Question: Write a single sentence explaining what this figure depicts.
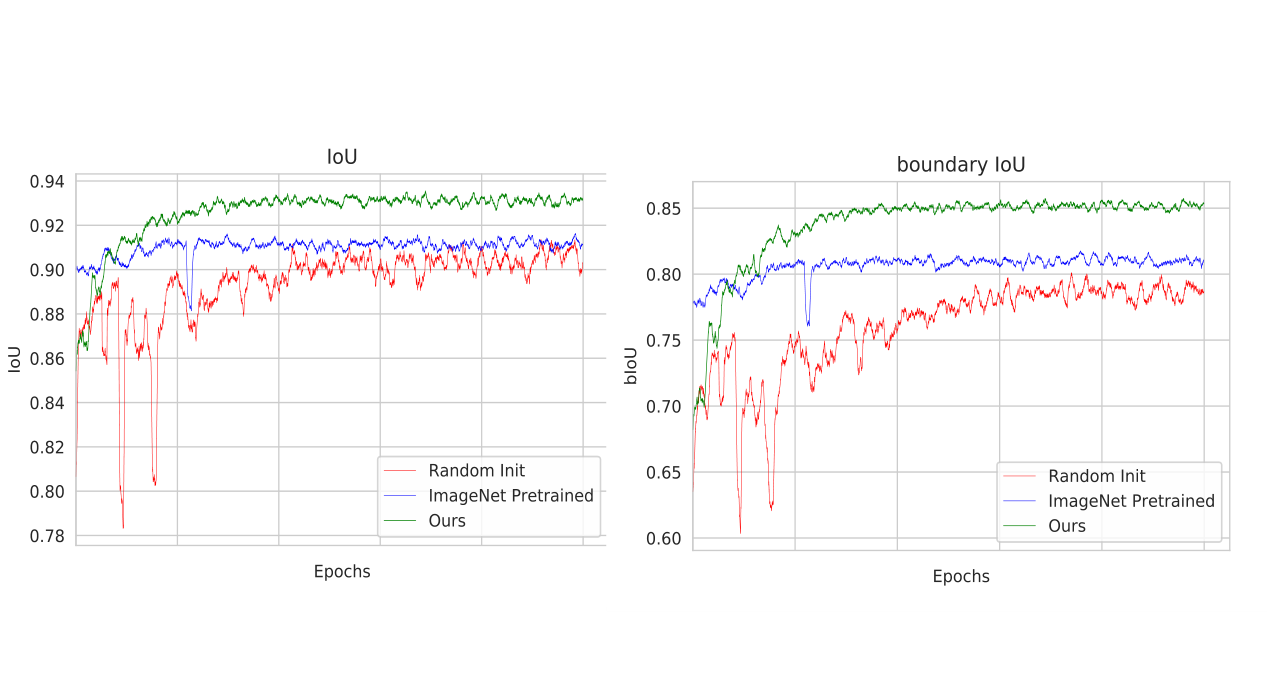
Answer: Training performance metrics of building segmentation on T2, with network initializations as described in Figure 8.